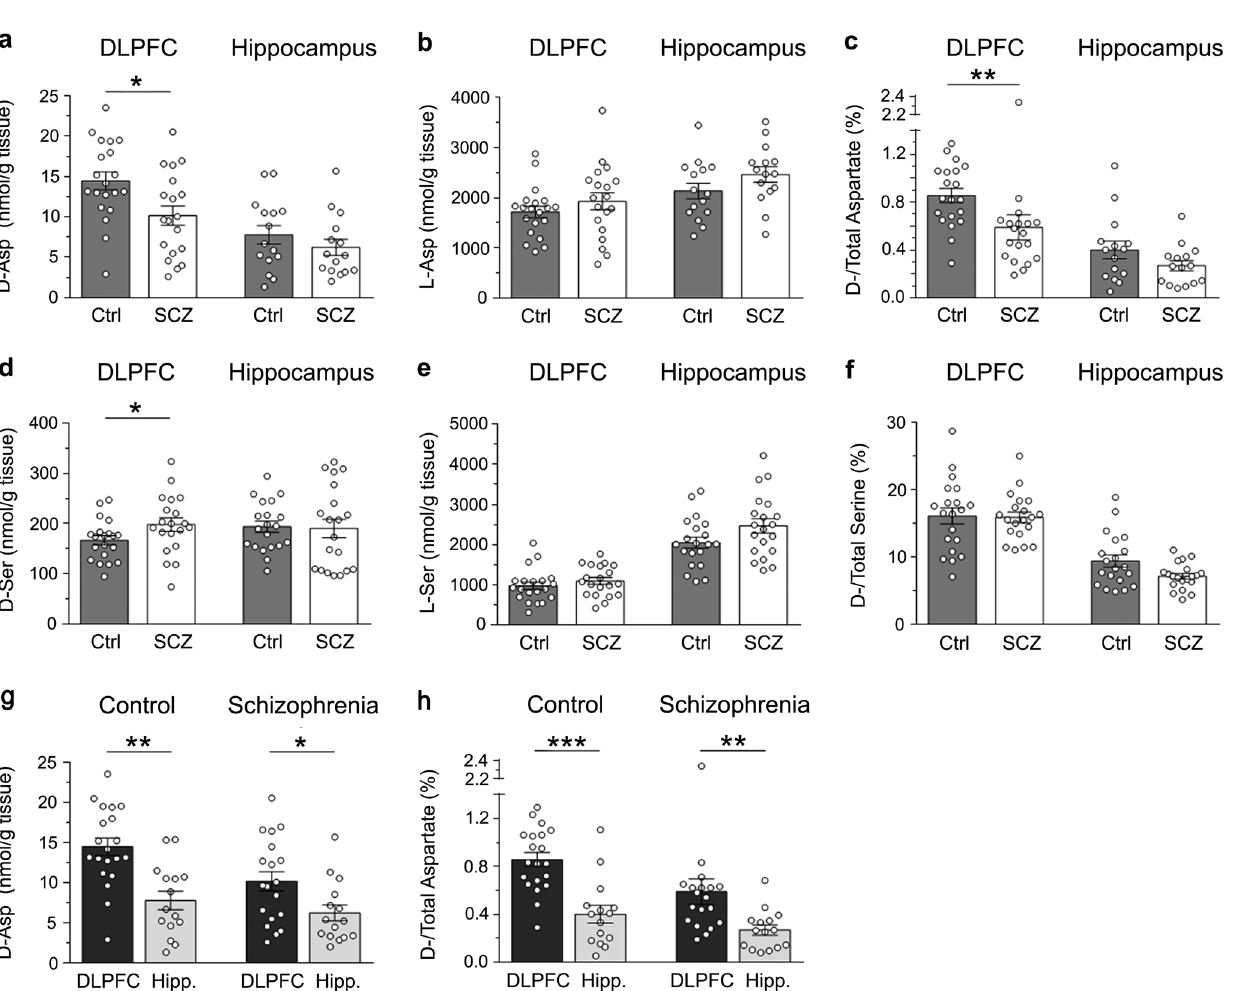
Fig. 2 Changes in D -aspartate and D -serine levels between patients with schizophrenia and control subjects in the post-mortem dorsolateral prefrontal cortex and hippocampus. a D -aspartate, b L -aspartate, d D -serine and e L -serine levels, c D -aspartate/total aspartate and f D -serine/ total serine are compared between non-psychiatric individuals (control, Ctrl) and patients with schizophrenia ( SCZ ) in the post-mortem dorsolateral prefrontal cortex ( DLPFC ) (Ctrl, n = 20; SCZ, n = 19) and hippocampus (Ctrl, n = 15; SCZ, n = 15). g, h D -aspartate levels and D /total aspartate ratio were also compared between the DLPFC and hippocampus (Hipp.) of non-psychiatric individuals (DLPCF, n = 20; hippocampus, n = 15) and patients with schizophrenia (DLPCF, n = 19; hippocampus, n = 15). In each sample, all the amino acids were detected in a single run by HPLC and expressed as nmol/g of tissue, while the ratios are expressed as percentage (%). * p < 0.05; ** p < 0.01; *** p < 0.0001 (Mann – Whitney test). Dots represent the single subjects ’ values while bars illustrate the means ±